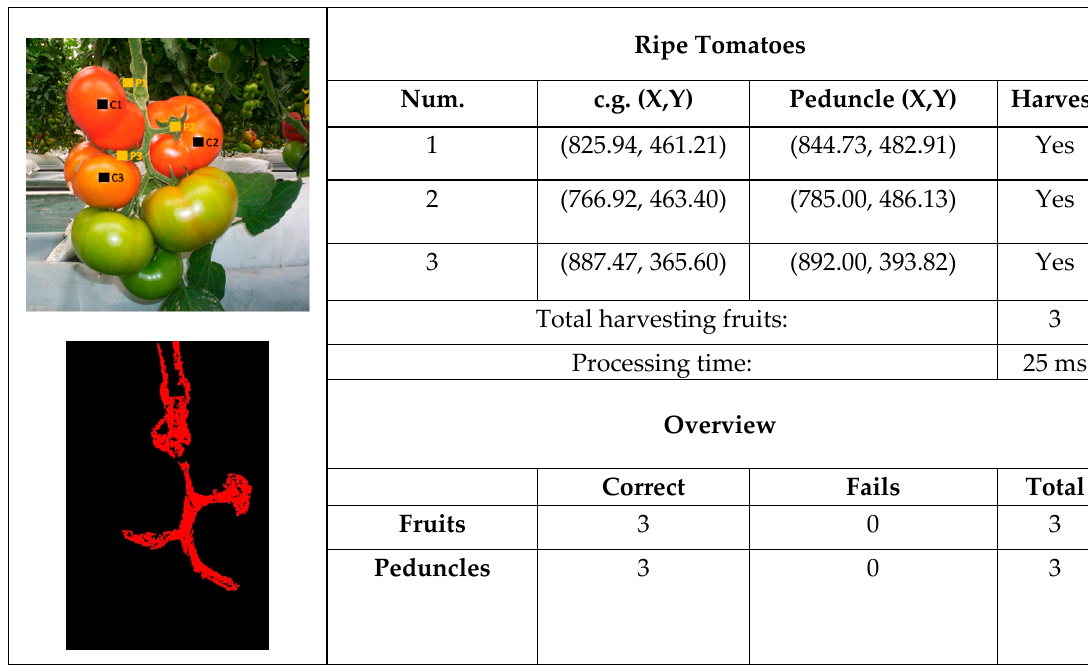
Figure 20. Beef tomatoes: centers, peduncle detection and results.